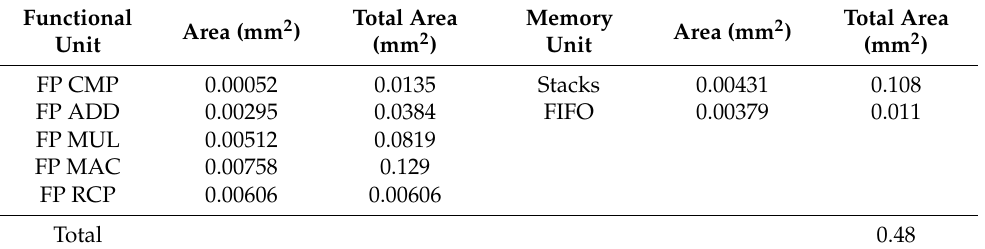
Table 5. Area estimates of RT engine.